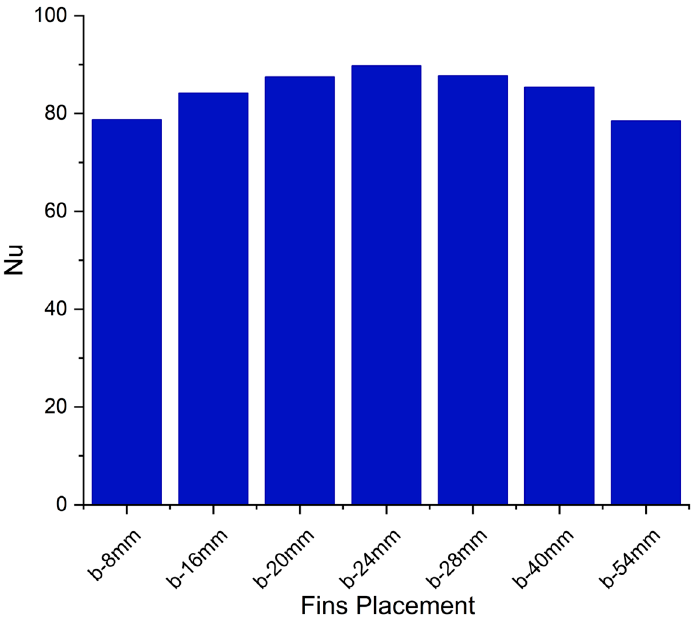
Figure 11. Average Nusselt number at different pitches.